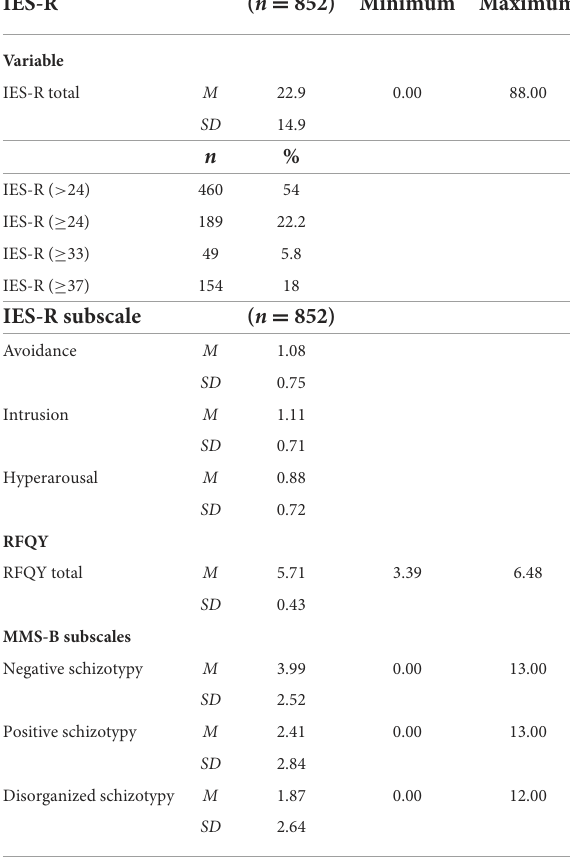
TABLE 7 IES-R, RFQY, and MMS-B descriptive results. TABLE 8 Means of significant variables in